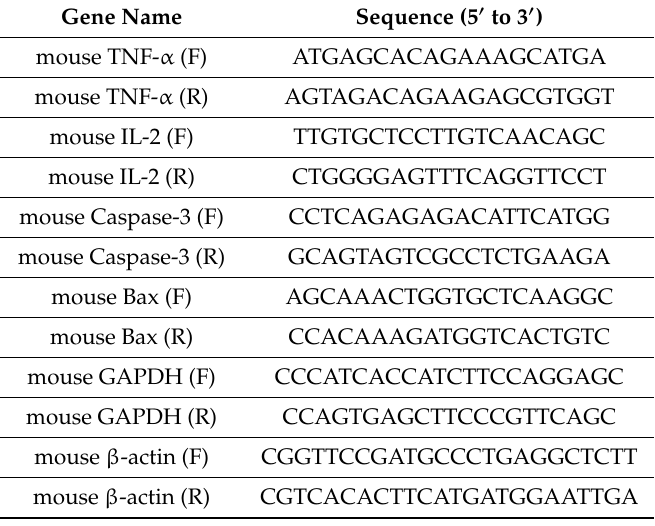
Table 1. Primer sequences for